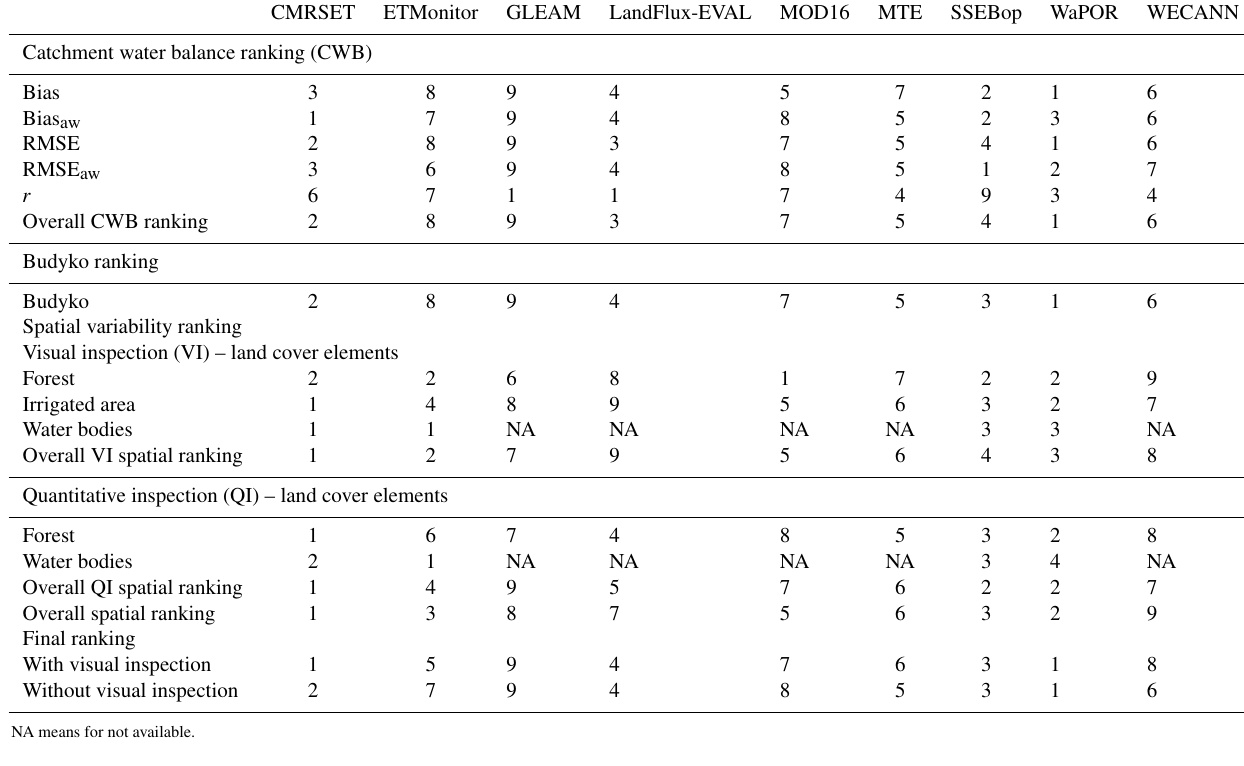
Table 9. Ranking of the ET products based on the different evaluation steps in the proposed methodology.